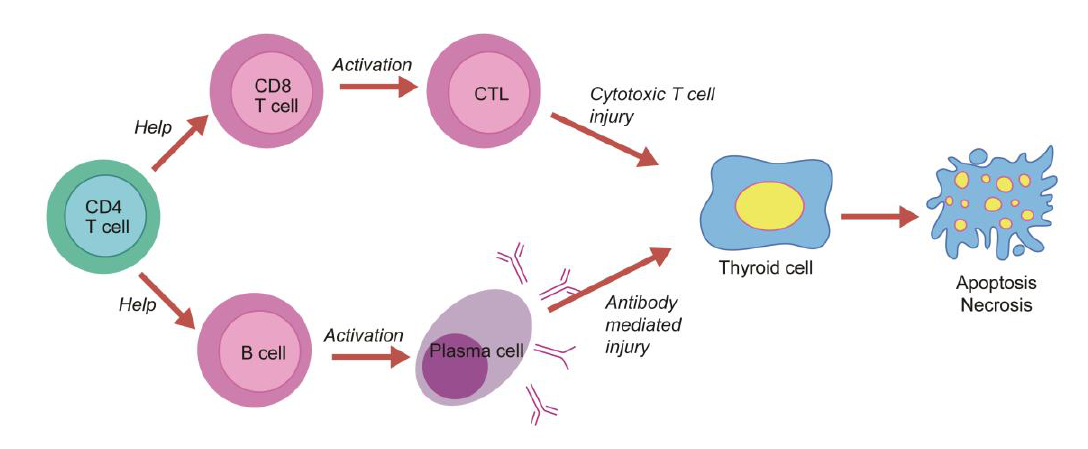
Figure 2.1. Pathogenesis of Hashimoto's thyroiditis (17). Dysregulation of humoral and cell mediated immune responses leads to destruction of thyroid cells over time.